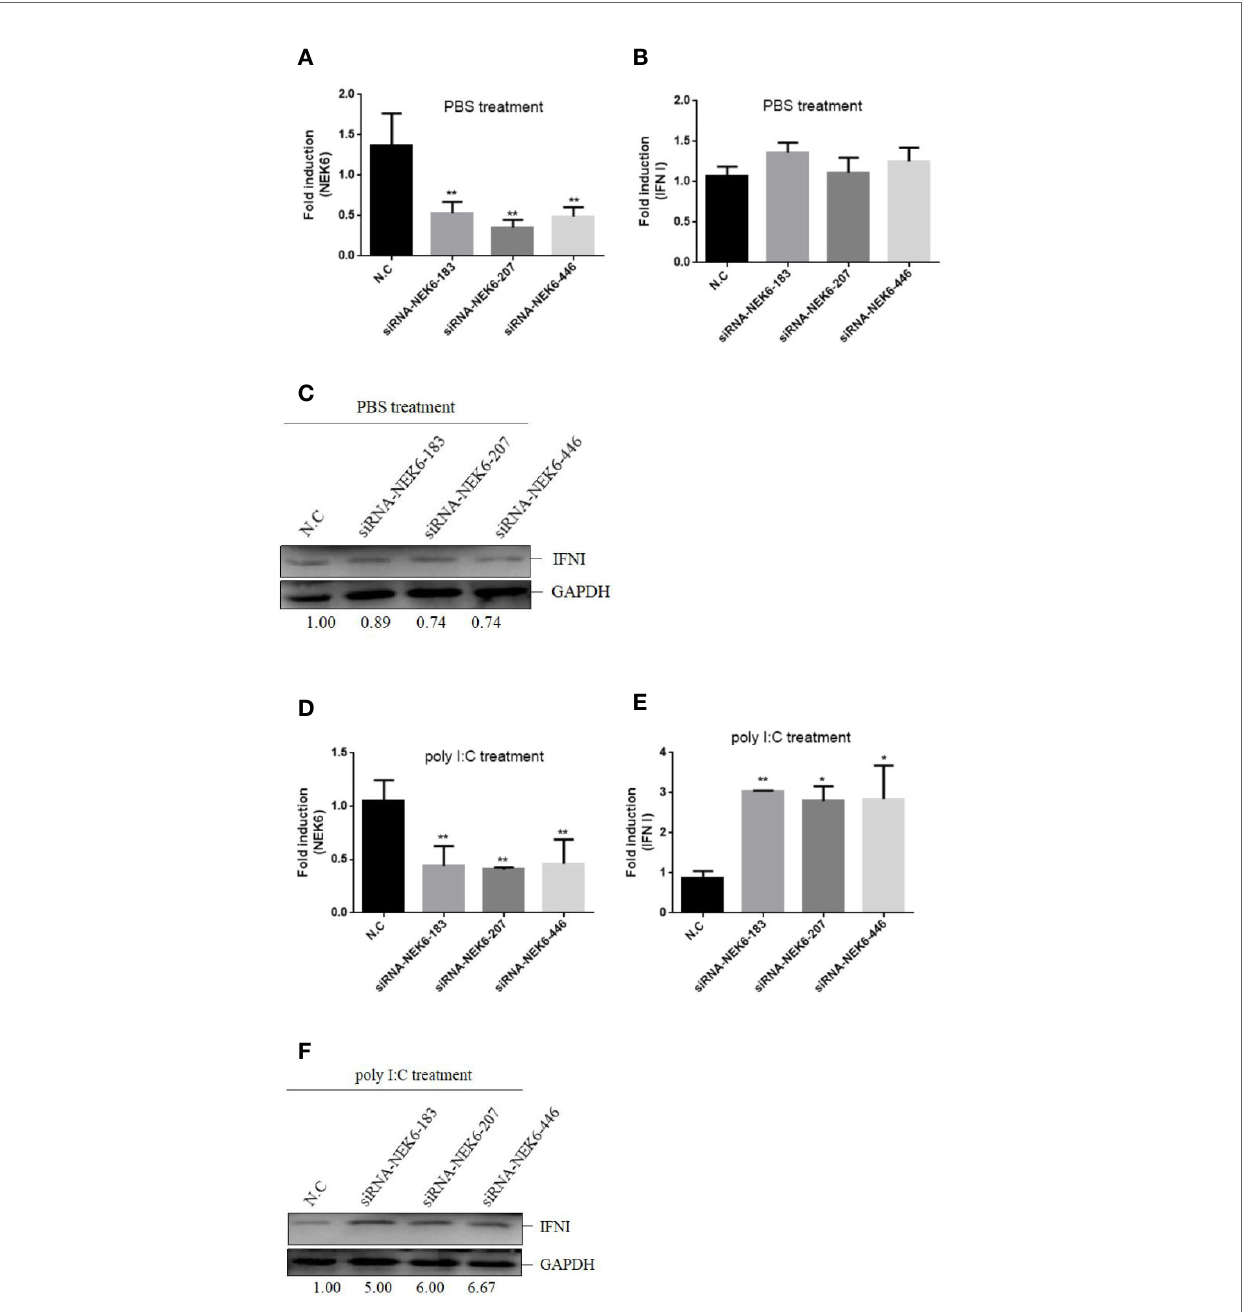
FIGURE 4 | Knockdown of CiNEK6 increases IFN I expression under poly I:C treatment. CIK cells were separately transfected with 2 m g of siRNA-NEK6-183, 2 m g of siRNA-NEK6-207, 2 m g of siRNA-NEK6-446, and 2 m g of negative controls (N.C). Then the cells were treated with PBS or poly I:C. The effect of knockdown was examined through qRT-PCR (A , D) . QRT-PCR (B , E) and Western blot (C , F) were used to monitor IFN I expression. *p < 0.05, **p <